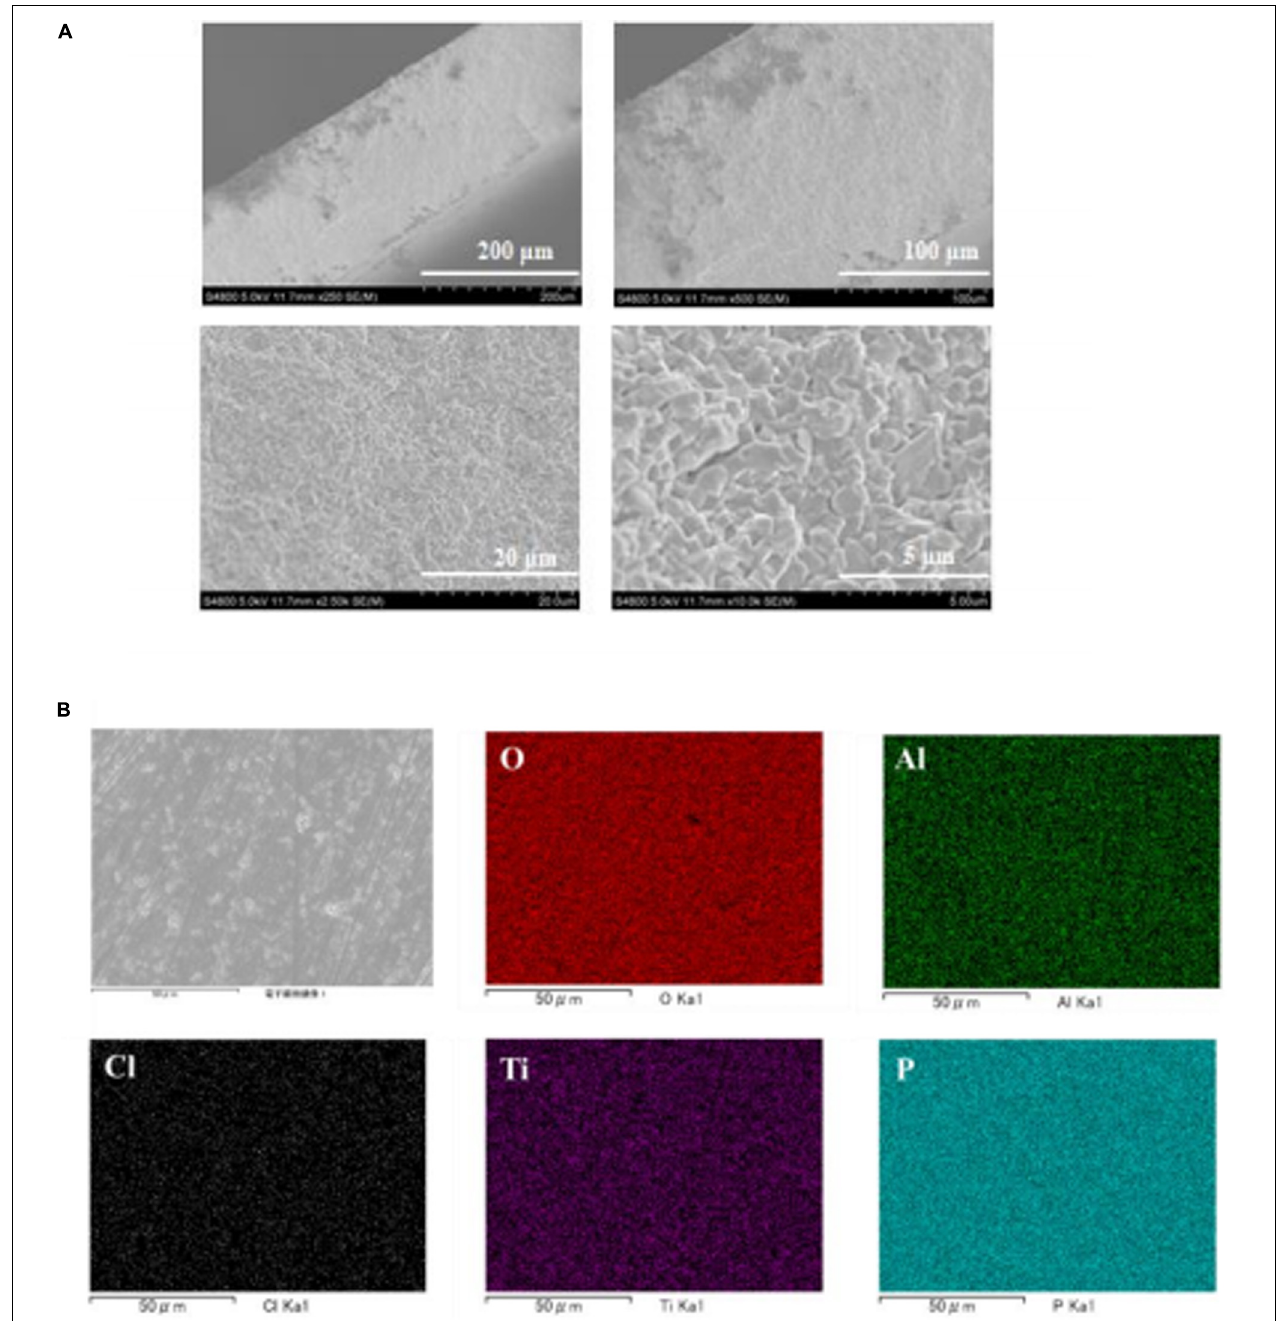
FIGURE 3 | (A) Cross-sectional SEM images and (B) EDX maps of LAGTP-E-LiCl.